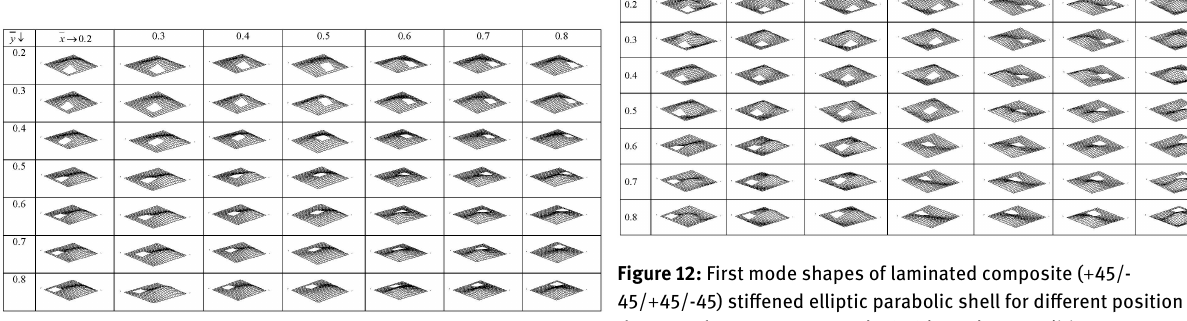
Figure 8: First mode shapes of laminated composite (0/90/0/90) stiffened elliptic parabolic shell for different position of the central square cutout and SCSC boundary condition.